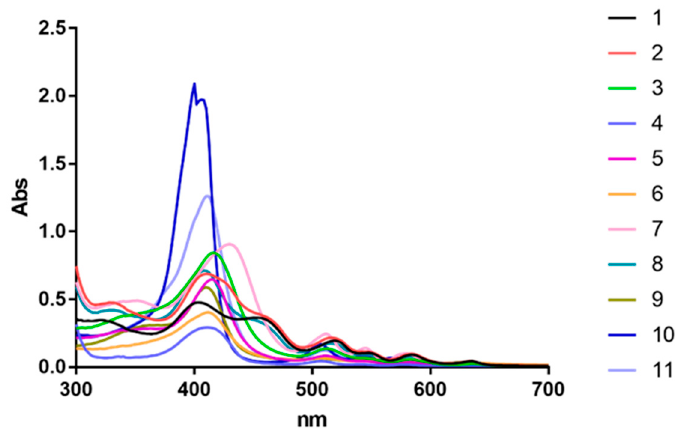
Figure 1. Visible light absorption spectra of the diaryl-porphyrins ( 1 – 11 ).